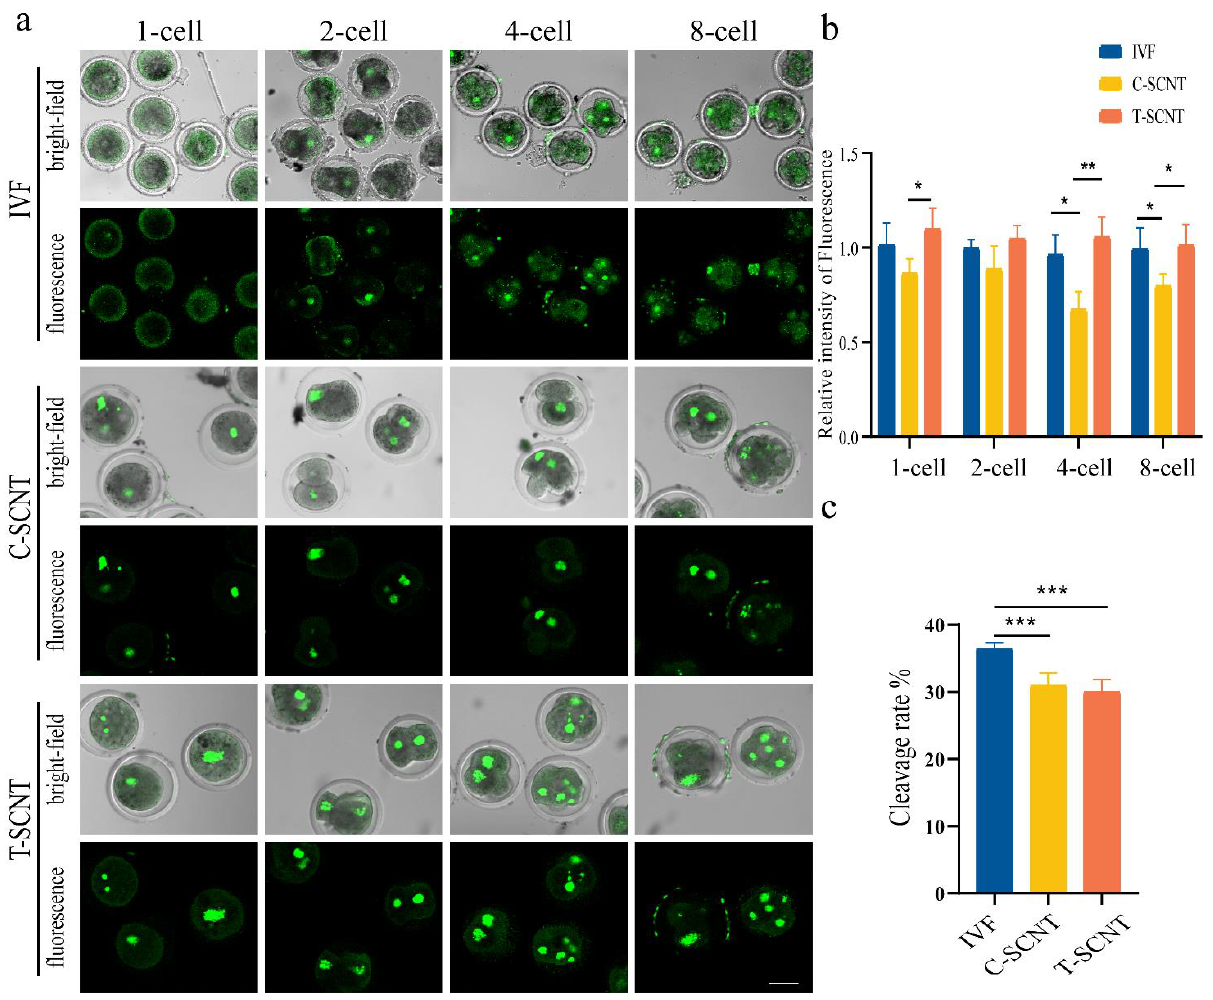
Figure 6. Effect of treatment of donor cells (FFCs) with NaCr on the level of H3K9cr and the developmental competence in SCNT embryos. ( a , b ) Fluorescence staining pattern and relative fluorescence intensity of the H3K9cr level in IVF and FFC SCNT embryos (C-SCNT and T-SCNT) at different stages (scale bar, 50 µm). ( c ) The cleavage ratios of embryos at all cleavage stages in IVF, C-SCNT, and T-SCNT. The C-SCNT (control SCNT) and T-SCNT (experimental SCNT) groups represent cloned embryos generated with untreated and NaCr-treated donor cells (FFCs), respectively. The IVF group represents a blank control group; * p < 0.05, ** p < 0.01, *** p < 0.001; no asterisk indicates no significant difference.